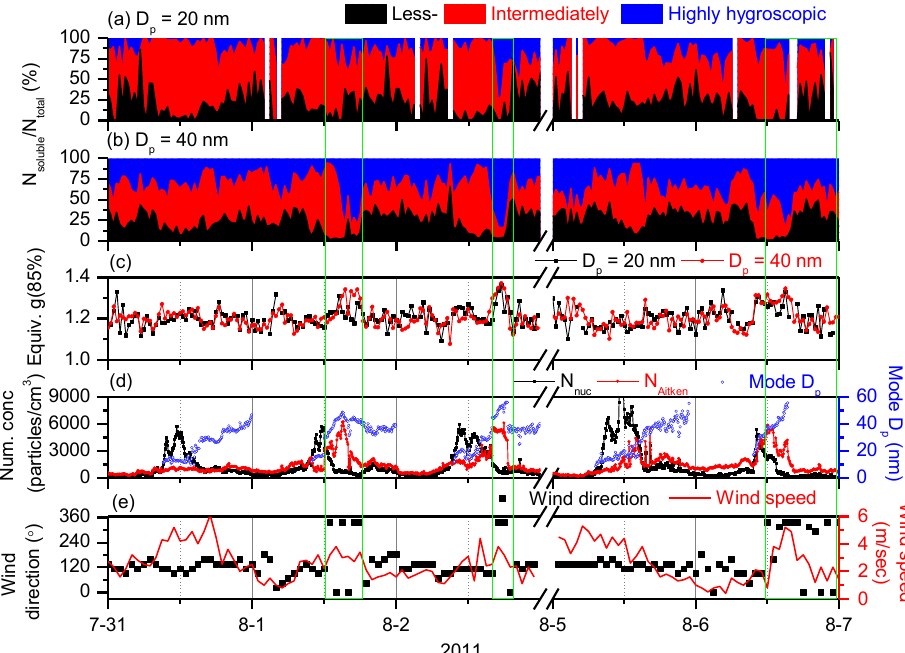
Figure 7. Temporal variations in number fractions of less-, intermediately, and highly hygroscopic particles at dry D p values of (a) 20nm and (b) 40nm. (c) g (85%) values of total particles at dry D p values of 20 and 40nm. (d) N nuc , Aitken (30–100nm) mode particles ( N Aitken ), and Mode D p during the periods 31 July–2 August and 5–6 August. (e) Temporal variations in wind direction and wind speed are also shown. Rectangles represent northwesterly or northeasterly wind